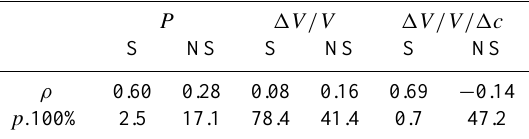
Table 3. Correlations between 0 . 189MeV / n He ion peak intensity and pressure peak P , relative change in the solar wind speed 1V/V and relative change in the solar wind speed per compression